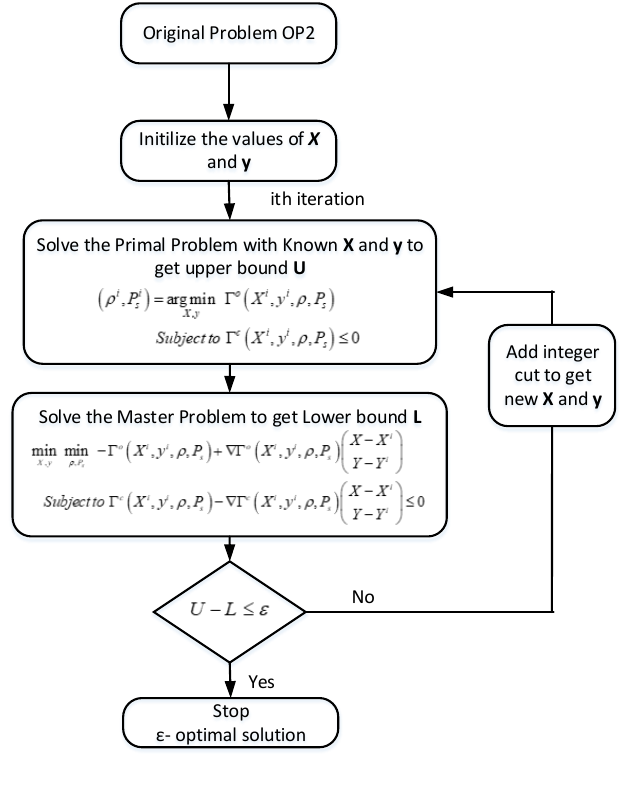
Figure 3. OAA Flow